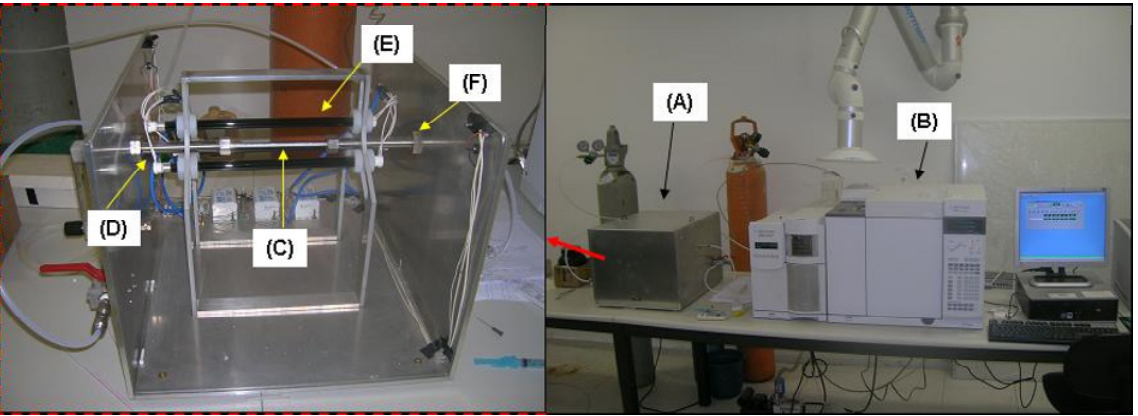
Figure 1. System used for testing photocatalytic activities: (A) Photoreactor system (B) Gas monitoring system (GC/MS); (C) UV grade fused silica tubular photoreactor; (D) Gas entrance; (E) UV lamp; (F) Gas